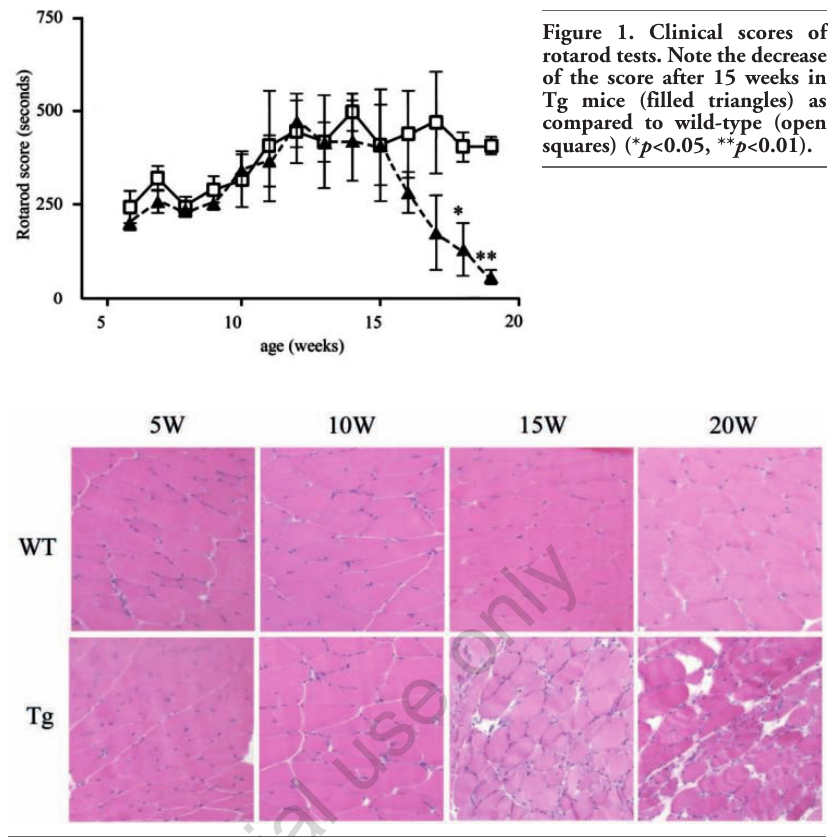
Figure 3. Double immuno-histochemistry of anti-SV2 antibody (green) and α -BuTX (red) in soleus muscles in wild- type (WT) and Tg mice. (A) Note the decrease of double positive NMJs from ten weeks in Tg (A, lower panels), and (B) the progressive decrease of the percentages of double pos- itive NMJs in Tg mice (filled triangles) from ten weeks compared with WT mice (open squares). (* p <0.05, ** p <0.01).